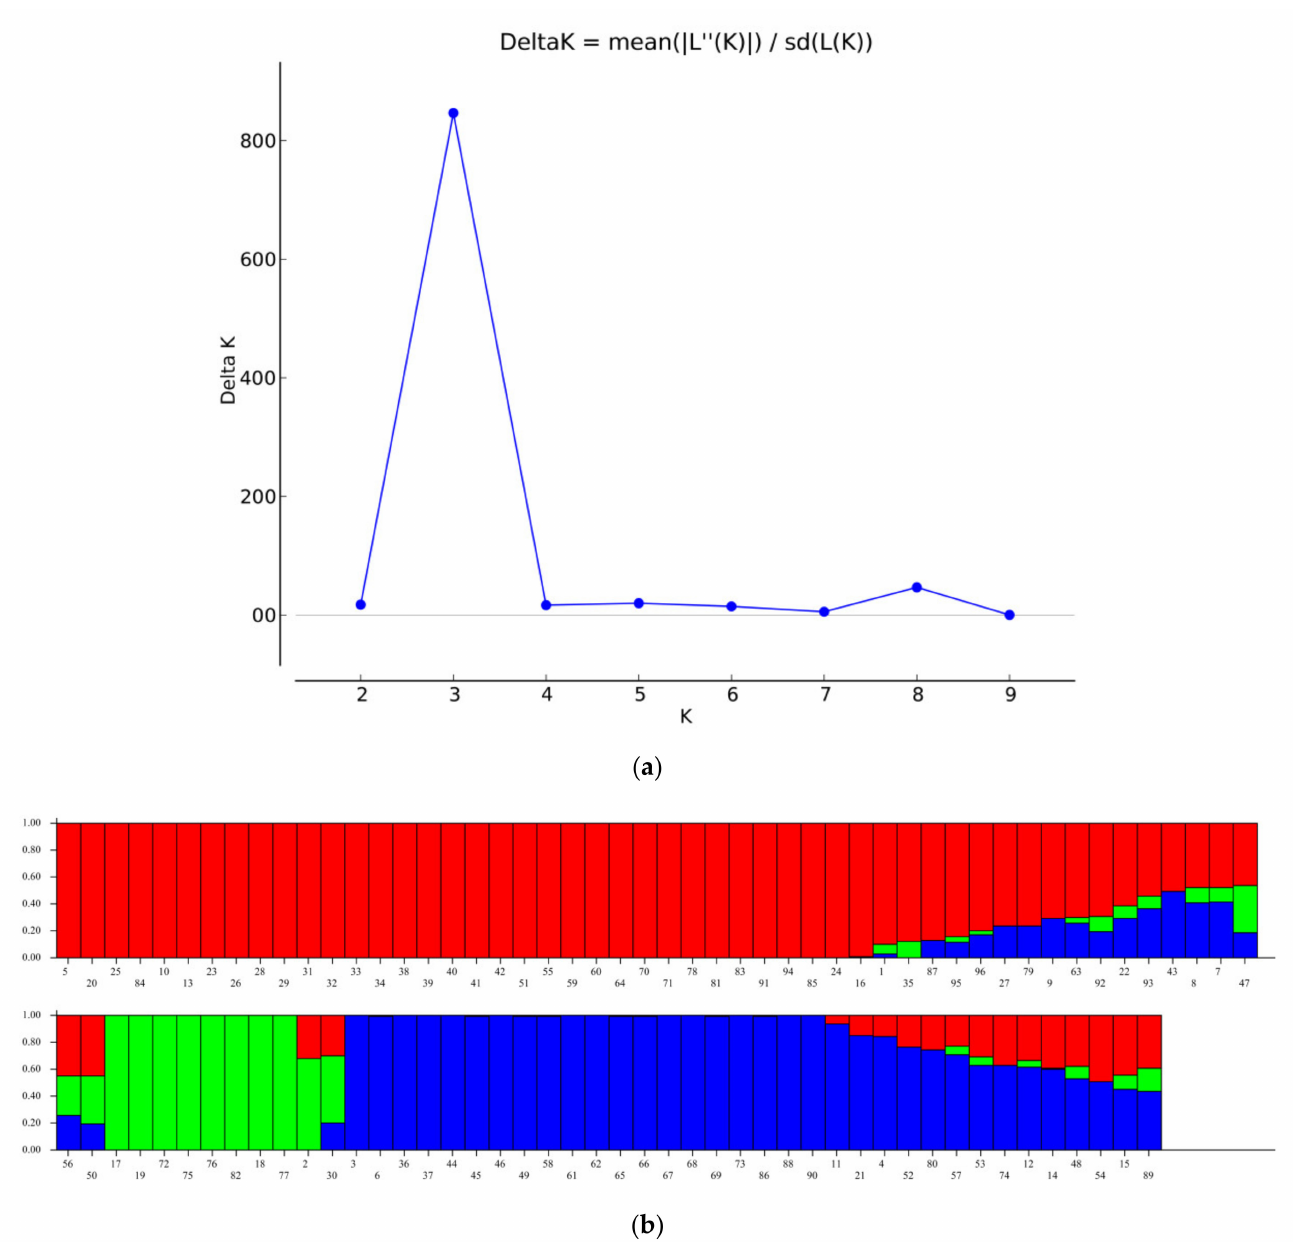
Figure 4. STRUCTURE analysis. ( a ) The ∆ K value was highest for the model parameter K = 3 than for other values of K. ( b ) The bar plot showing each rice variety belonging to three